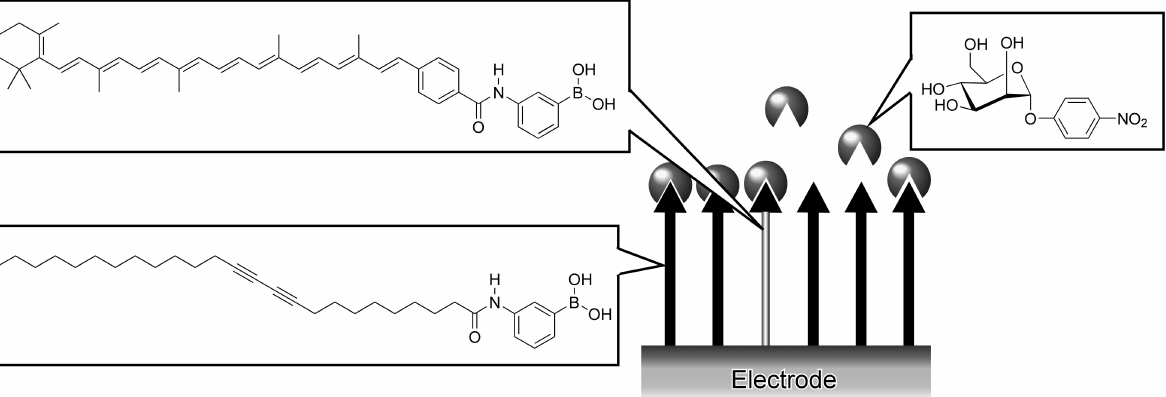
Figure 3. Recognition of sugar guest by boronic acid LB films. Reprinted with permission from [42] ©2004, American Chemical